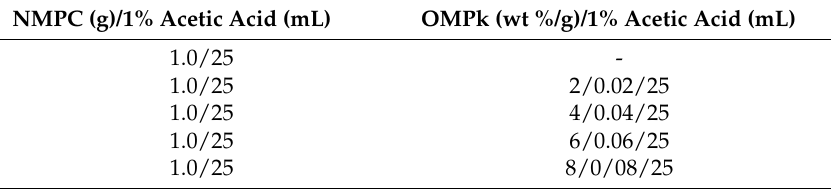
Table 1. Chemical composition of N -methylene phosphonic chitosan (NMPC)- O -methylene phosphonic κ -carrageenan